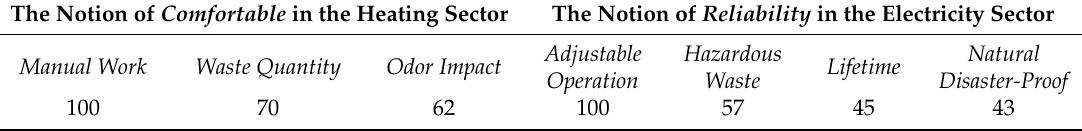
Table 6. Ranking of the sub-criteria assigned to different main criteria on a scale of 0–100, until threshold K i.